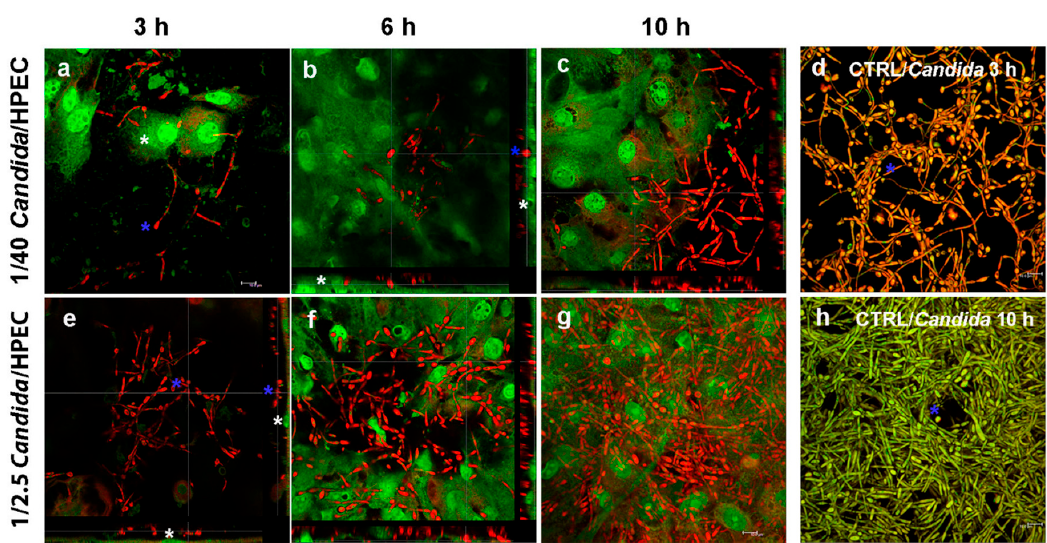
Figure 2. The C. albicans - human palate epithelial cell (HPEC) invasion process after direct contact (DC) with different ratios of Candida /HPEC. ( a and e ) Filamentous fungus (blue asterisk) at the periphery of epithelial colonies; filaments positioned on the epithelial cells (white asterisk) without epithelial invasion. ( b ) Initial intraepithelial invasion (active epithelial penetration) by the fungus (blue asterisk). HPECs are stained in green (white asterisk). ( c, f, and g ) Intensified intraepithelial invasion due to the increased C. albicans concentration and density of prolific filamentous forms over time. ( d and h ) The fungal biofilm (blue asterisk) in the absence of epithelial cells (CTRL/ Candida ) that is qualitatively more intense than the one in the presence of HPECs. Acridine orange staining (confocal laser-scanning microscopy, 630×